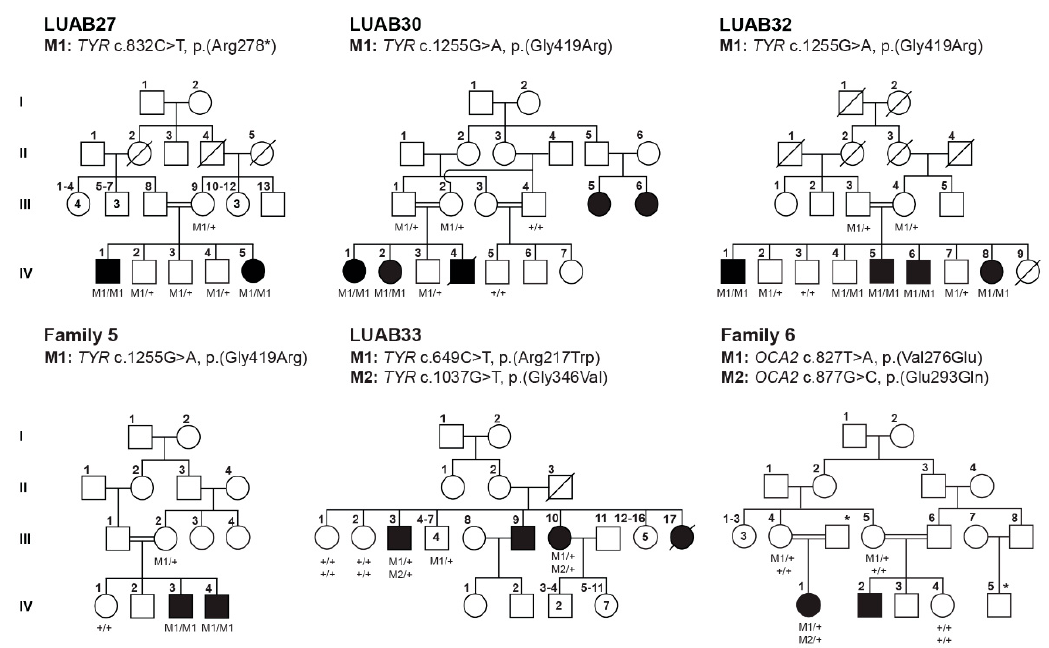
Figure 1. Pedigrees of Pakistani families segregating nonsyndromic OCA due to single-gene variants are shown. Genotypes are mentioned below each sequenced individual, while the identified variants and gene names are listed on top of each pedigree. Empty and filled symbols represent the normal and affected individuals, respectively. A double line between two individuals represents a consanguineous marriage.